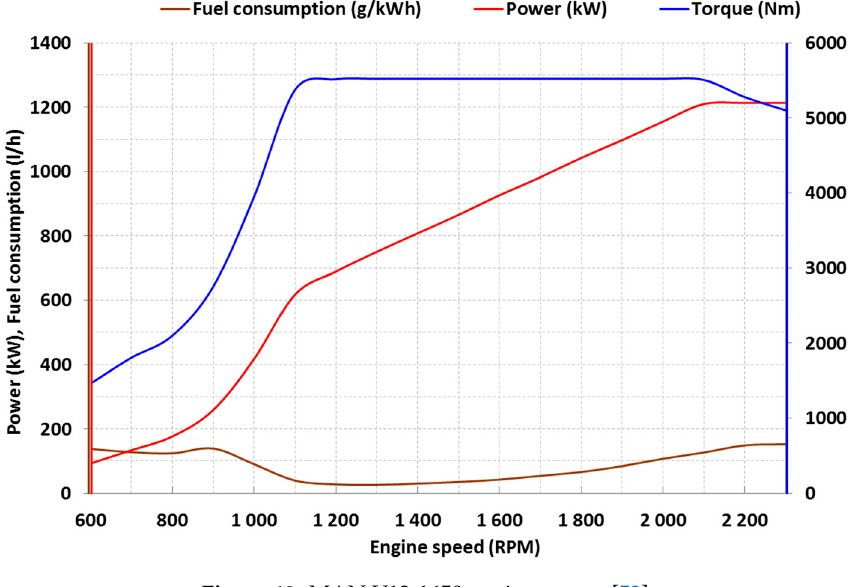
Figure 12. Model of a MAN V12-1650 diesel engine developed in Modelica.